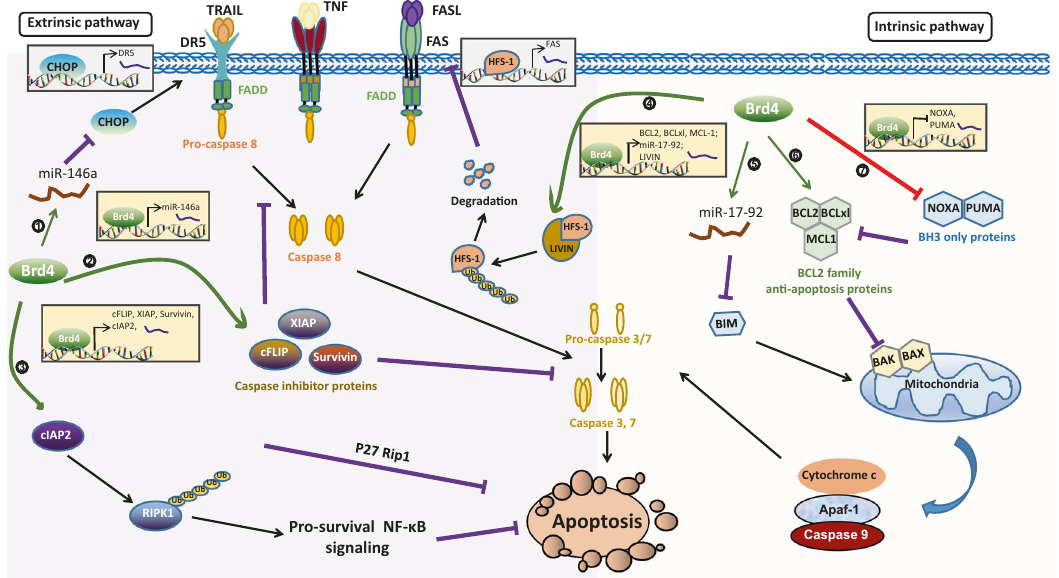
Fig. 1 Schematic model for the transcriptional regulation of Brd4 in cellular apoptosis. Brd4 can inhibit apoptosis through both intrinsic (mitochondrial) and extrinsic (death receptor-mediated) mechanisms by regulating the expression of many key components of these pathways. Brd4 directly or indirectly either upregulates the expression of genes coding anti-apoptotic proteins (BCL-2, BCL-xL, MCL-1, LIVIN, cFLIP, XIAP, Survivin and cIAP2) or downregulates the expression of genes coding pro-apoptotic proteins (NOXA, PUMA, BIM and